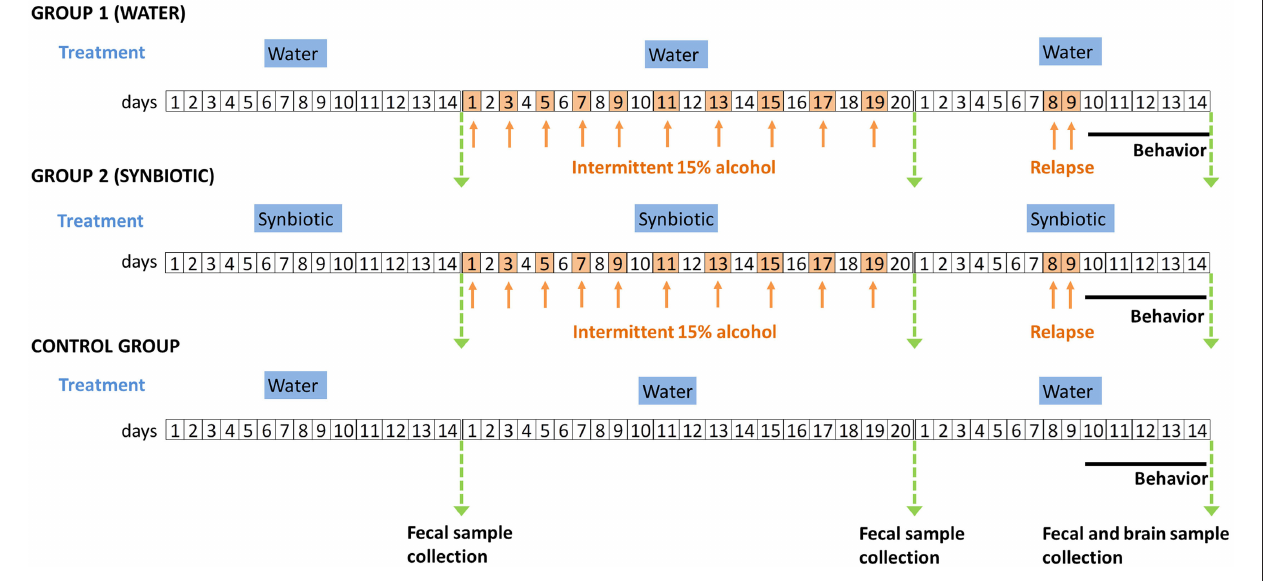
The PCR was performed in 10 µ l final volume with 0.2 µ